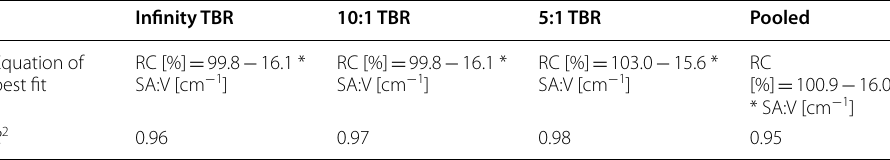
Table 4 Results of the regression analysis between the recovery coefficient (RC) and surface area- to-volume (SA:V) ratio for the infinity, 10-to-1, 5-to-1, and pooled target-to-background ratios of all kidney phantoms in the study Infinity TBR 10:1 TBR Pooled Equation of best